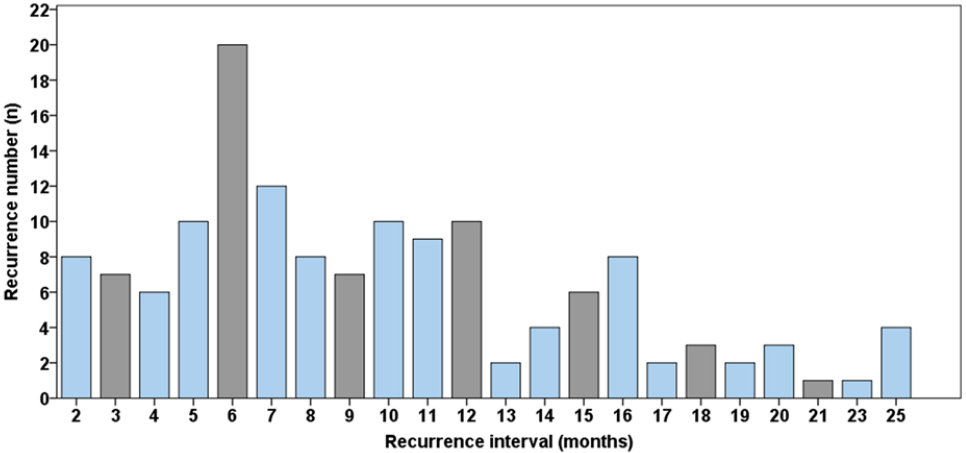
Figure 1. Distribution of recurrence interval of the relapse cases ( n = 216).